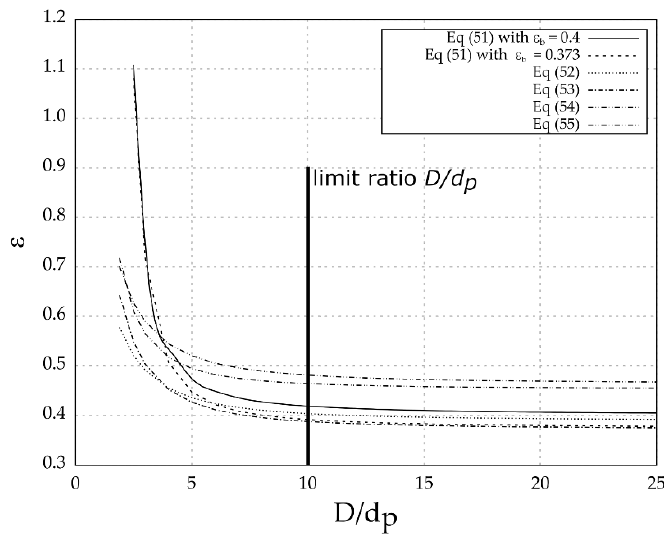
Figure 5. Dependence of mean voidage on the ratio D / dp .